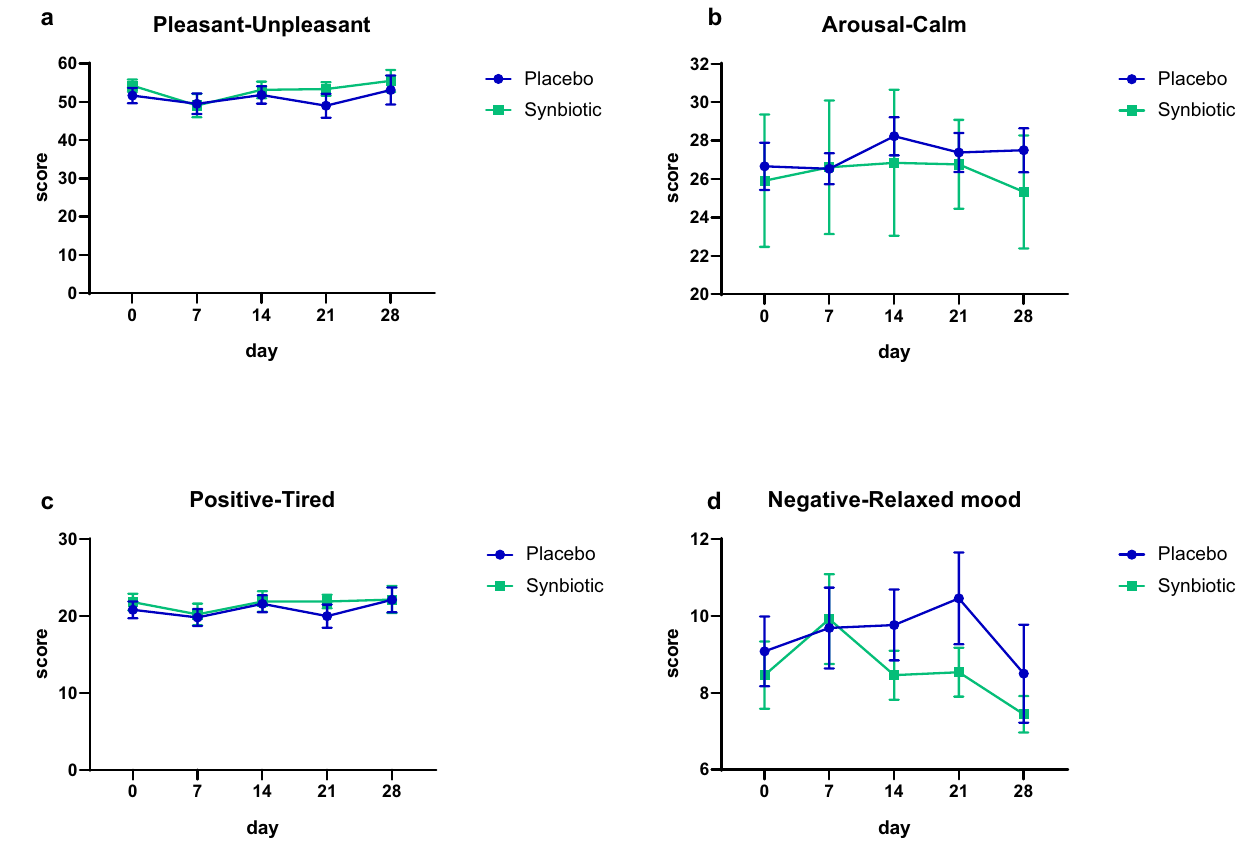
Figure 2. Mood subscales determined according to the Brief Mood Introspection Scale (BMIS) in middle-aged adults receiving placebo or synbiotic for 30 days. Values are means ± SEM (placebo: n = 14, synbiotic: n = 13; p > 0.05; mixed model